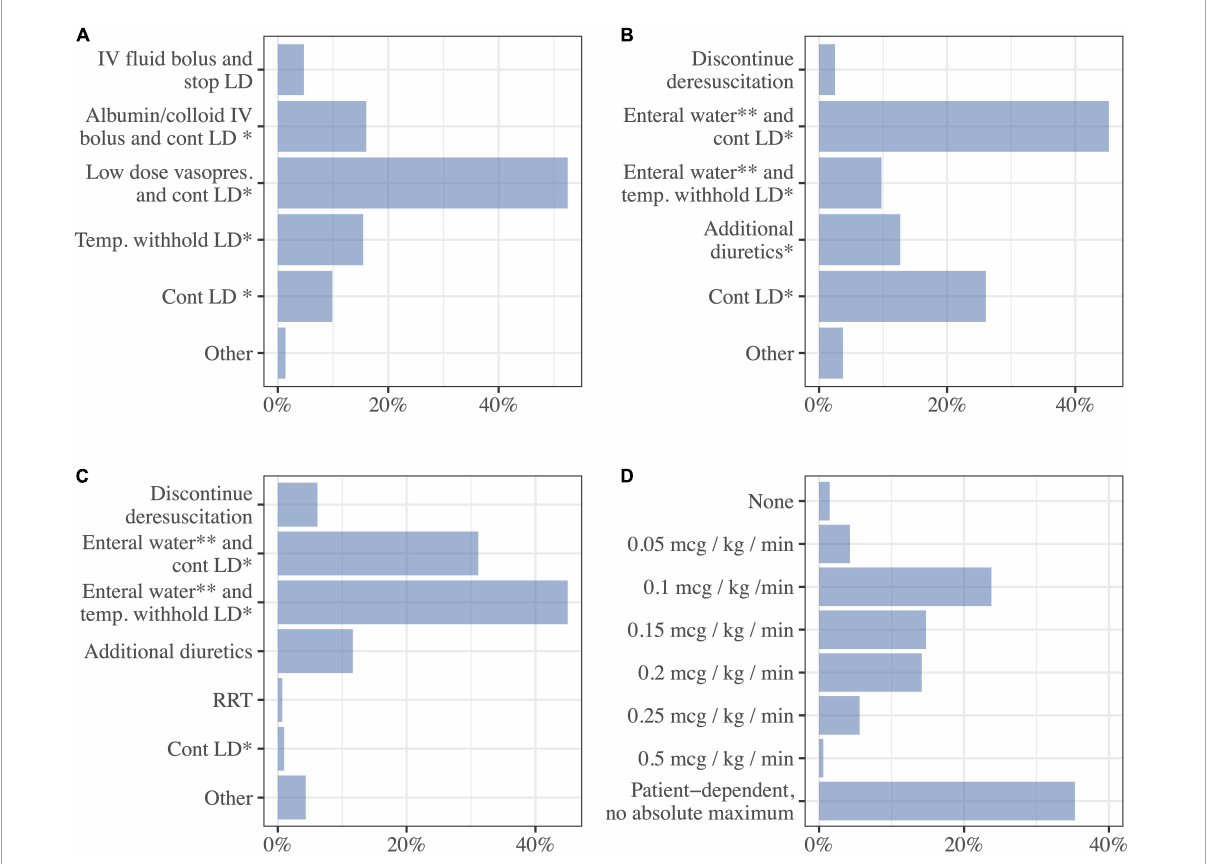
FIGURE10 Complications and contraindications. Answer the following questions while you assume you are attending a stable critically ill patient with fluid overload, who is treated with loop diuretics to achieve a negative fluid balance. Choose the option that best describe your likely